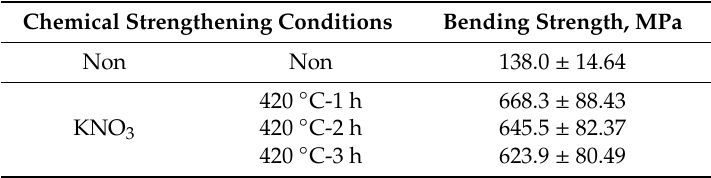
Table 5. Results obtained by bending